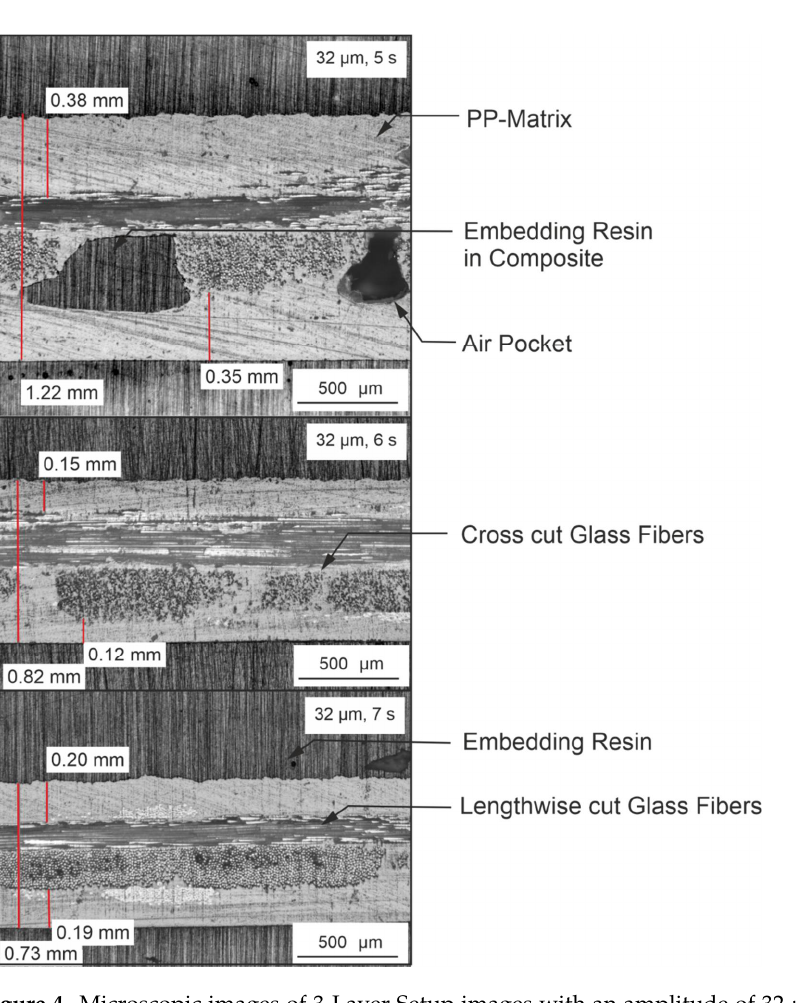
Figure 4. Microscopic images of 3-Layer Setup images with an amplitude of 32 µm and welding times between 5 and 6 s.